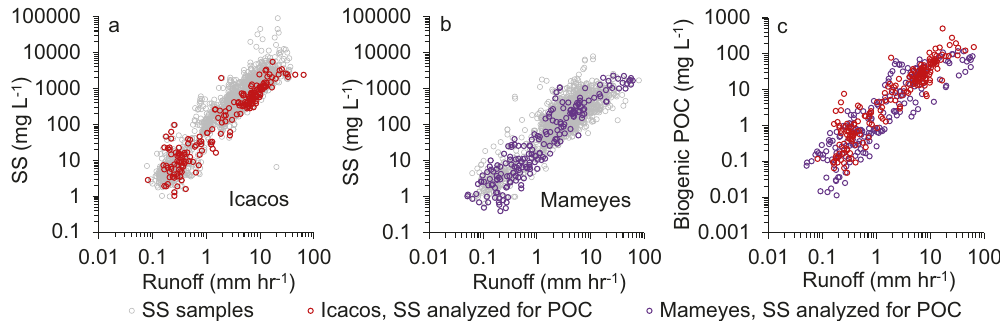
Fig. 1 River constituent concentrations in relation to runoff in the Luquillo Mountains. The relationship between river suspended sediment (SS mg L − 1 ) relative to river runoff (mm hr -1 ) for a Icacos and b Mameyes, with SS samples analyzed for particulate organic carbon (POC)% represented by colored circles. c Relationship between measured biogenic POC (mg L − 1 ) relative to runoff. Biogenic POC (mg L − 1 ) was estimated from SS samples that were not measured for POC% (gray circles) using Eq. 5 for Icacos and Eq. 6